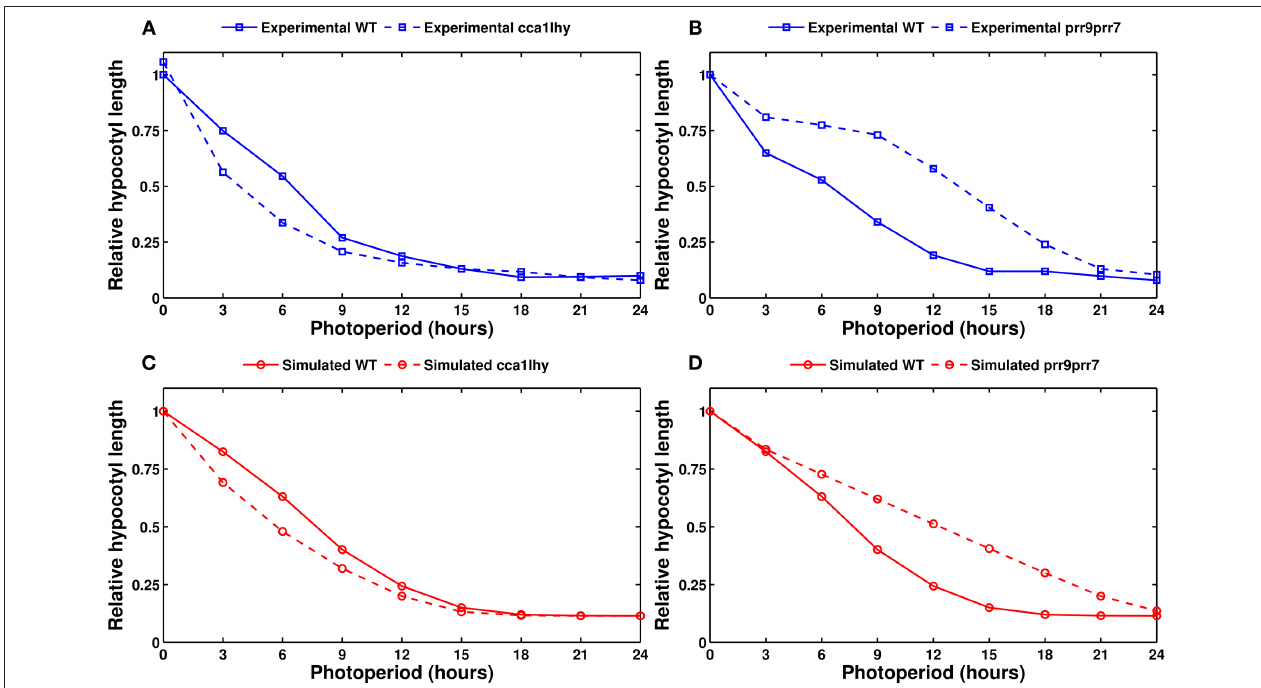
FIGURE 9 | Modeling hypocotyl growth. All panels show the measured or simulated hypocotyl length after 5 days of growth, relative to the length of the wild type in complete darkness. (A) Experimental data for the wild type (solid line) and the cca1lhy double mutant (dashed line). (B) Experimental data for the wild type (solid line) and the prr9prr7 double mutant (dashed line). (C) Simulated data for the wild type (solid line) and cca1lhy (dashed line). (D) Simulated data for the wild type (solid line) and prr9prr7 (dashed line). Experimental data from Niwa et al.